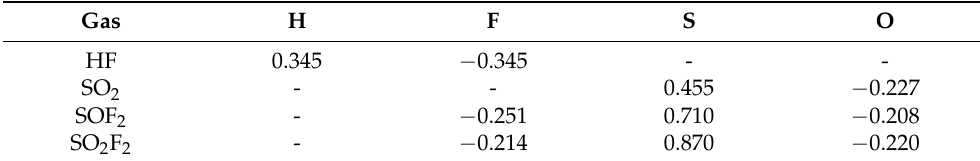
Table 2. Single atomic charges of gas